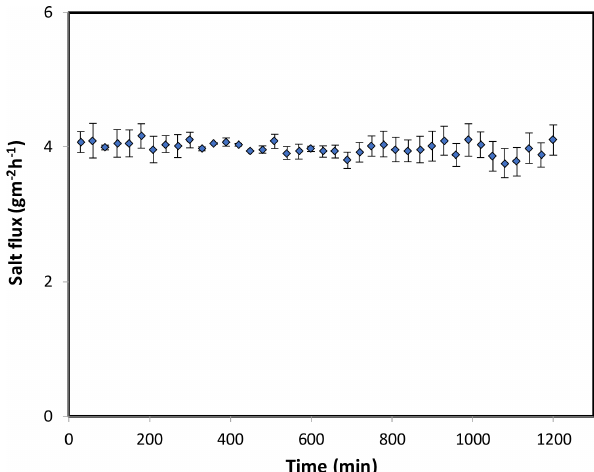
Figure 8. Forward osmosis salt flux for the PAN-TFC mem- brane. Experimental conditions: feed solution: DI water, draw so- lution: 1M NaCl, FO mode, volumetric flow rate of feed and draw 0.6Lmin − 1 , temp 25 ◦ C, zero transmembrane pressure. Results are an average of three experiments with different trails. Error bars in- dicate standard